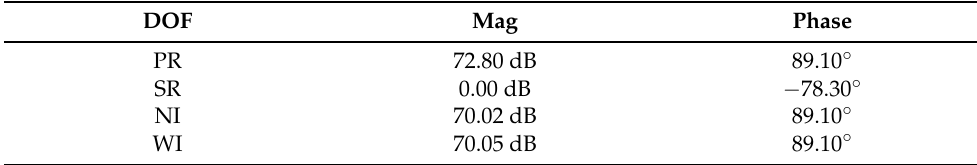
Table 3. Optical gains (in dB, normalized over the smallest) and demodulation phases (in degree) of the simulated signals shown in Figure